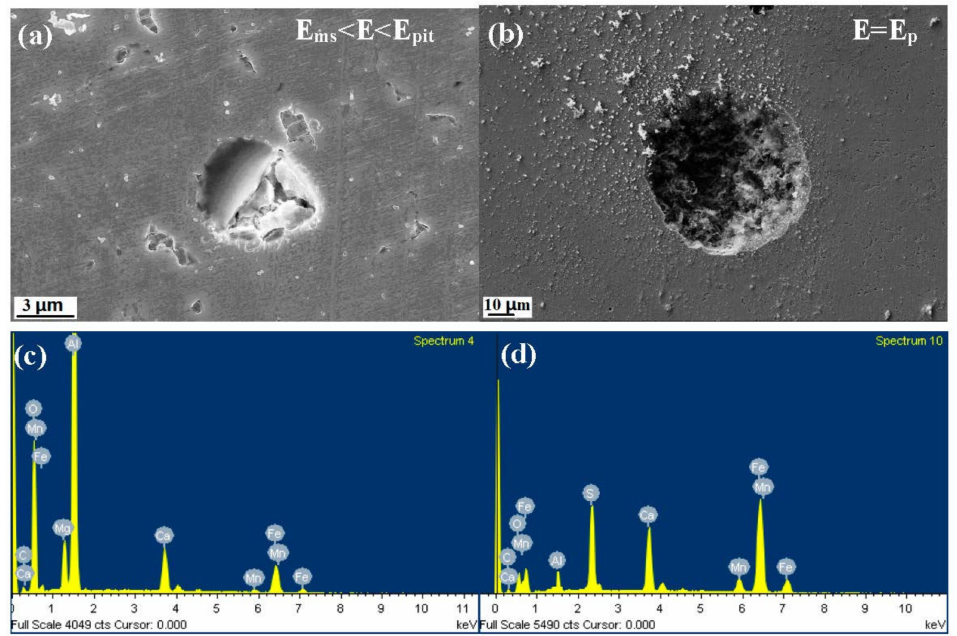
Figure 4. The morphology and EDS analysis of metastable pits at type A inclusion sites after the potentiodynamic polarization test. ( a , c ): E ms < E < E pit ; ( b , d ): E = E pit